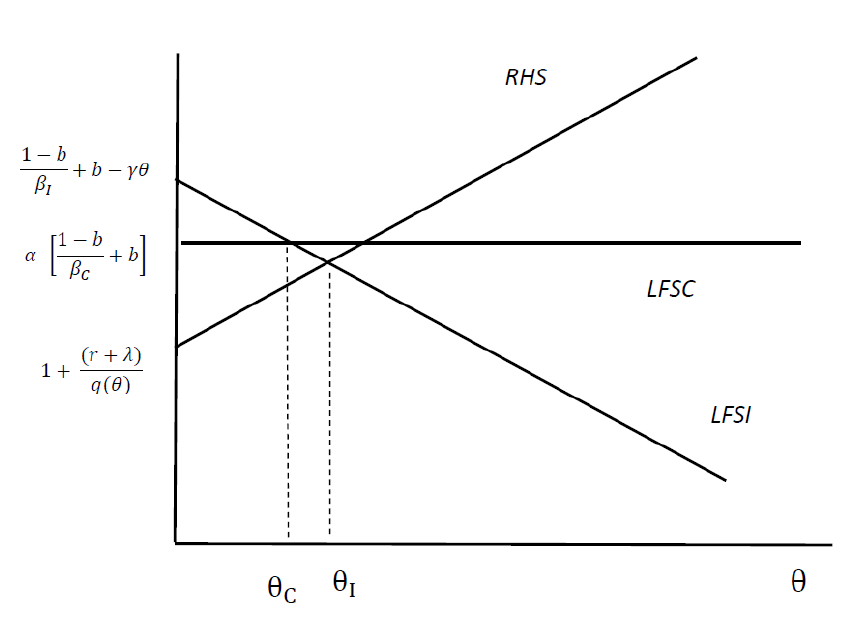
Figure 2: Demonstration of proposition